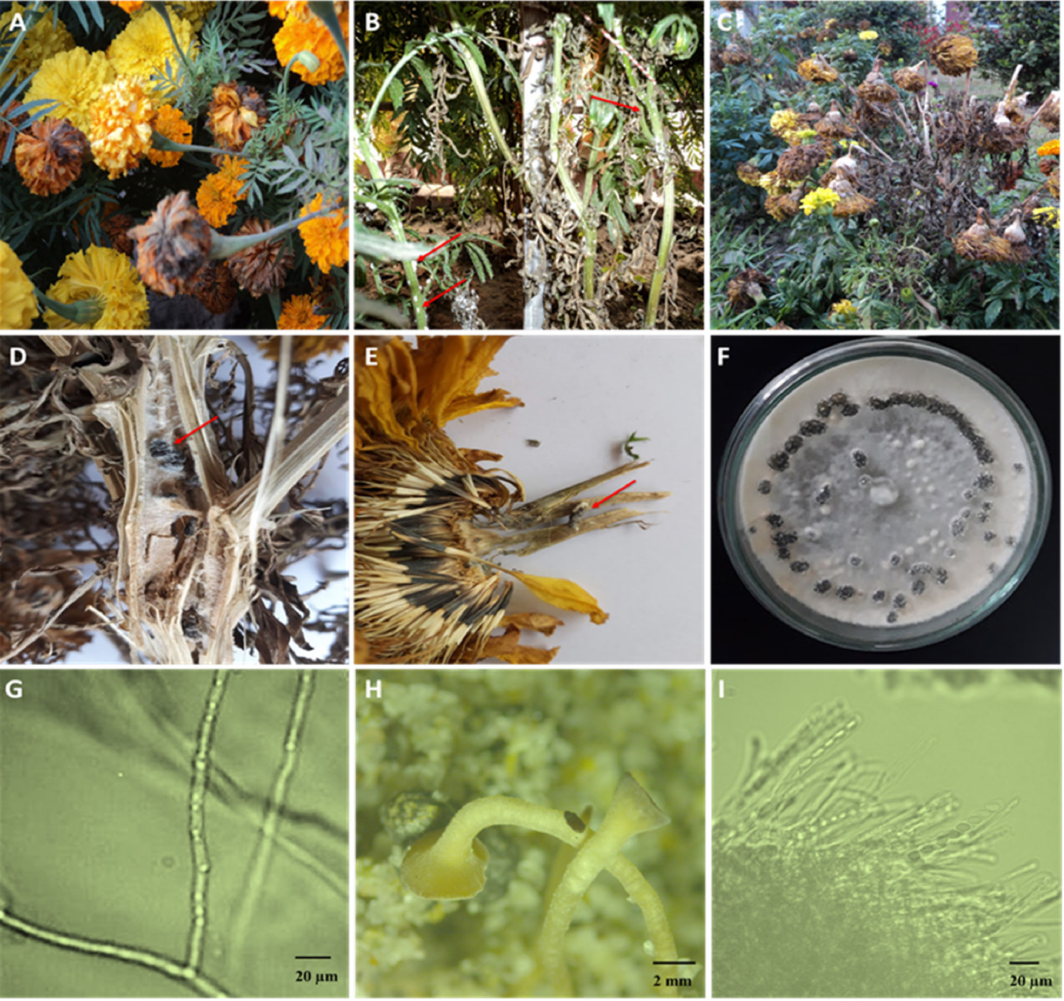
Figure 1. Infected marigold plants and the isolated fungus. ( A ) Infected marigold plants showing white mycelium growth (indicated by arrows). ( B ) Infected flower buds showing white rot symptoms. ( C ) Severely infected garden showing infected, wilted, and dried plants. ( D ) Infected stem showing sclerotial development in the internal pith tissues (indicated by arrows). ( E ) Infected marigold flower with external and internal brown discoloration with embedded black sclerotia (indicated by arrows). ( F ) Pure culture of the infected fungus showing fluffy white mycelium and sclerotial ring. ( G ) Micrograph of the mycelium of Sclerotinia sclerotiorum isolated from marigold plants. ( H ) Induced formation of mature apothecia. ( I ) Rows of asci containing